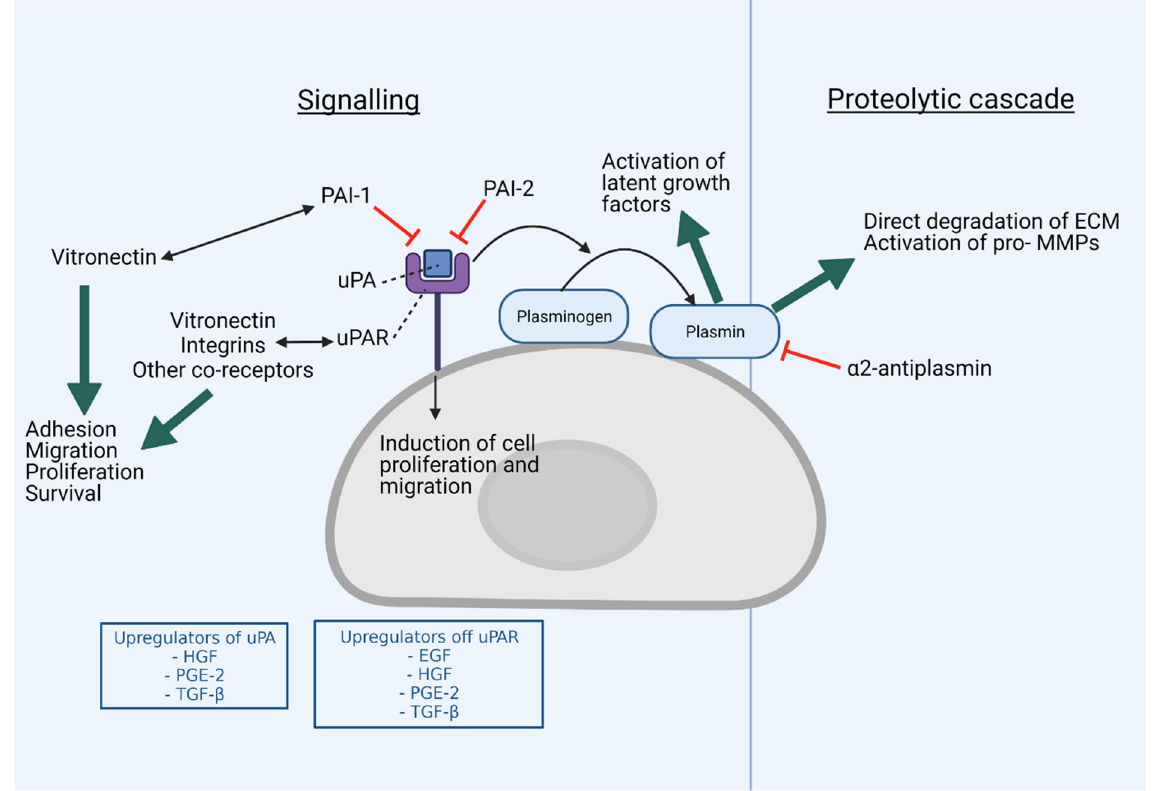
Figure 1. Overview of the urokinase plasminogen activation system. The binding of urokinase plasminogen activator (uPA) to its receptor, urokinase plasminogen activator receptor (uPAR) and generation of cell surface localised plasmin (which is protected from inhibition by α 2-antiplasmin) instigates multiple extracellular and intracellular (signaling) effects resulting in tissue remodeling and cellular proliferation, cell survival as well as altered cellular adhesion and migration. In cancer, uPAS components including uPA, uPAR and plasminogen activator inhibitor-1 (PAI-1) are upregulated in an uncontrolled fashion and contribute to inappropriate cell signaling and proteolysis. Upregulators of the plasminogen activation system include, but are not limited to, the Epidermal Growth Factor (EGF), Hepatocyte Growth Factor (HGF), Prostaglandin-E2 (PGE-2) and Tumour Growth Factor-beta (TGF- β ). See text for details. Created with BioRender.com (accessed on 17 June 2021).